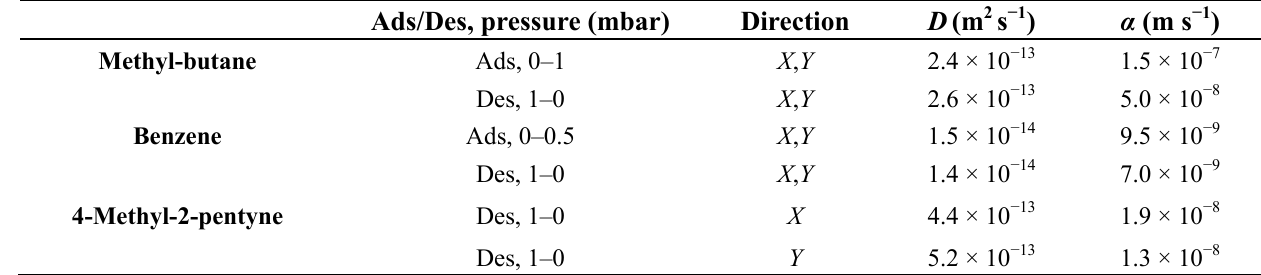
Table 1. Diffusion coefficients D and surface permeabilities α at room temperature ( ≈ 295 K) for methyl-butane, benzene and 4-methyl-2-pentyne as guest molecules in the